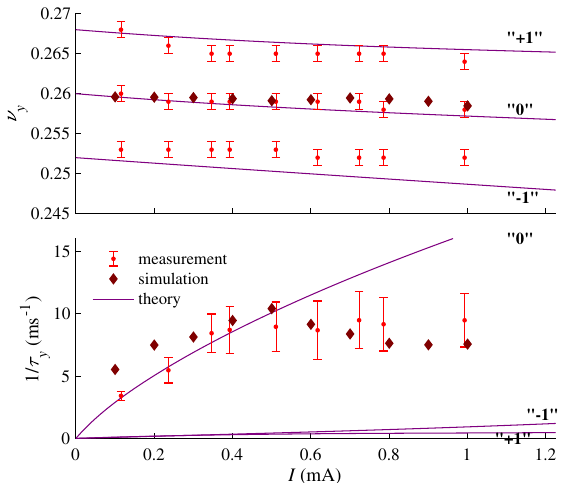
FIG. 8. Frequencies (top) and damping/growth rates (bottom) of vertical head-tail modes; ξ